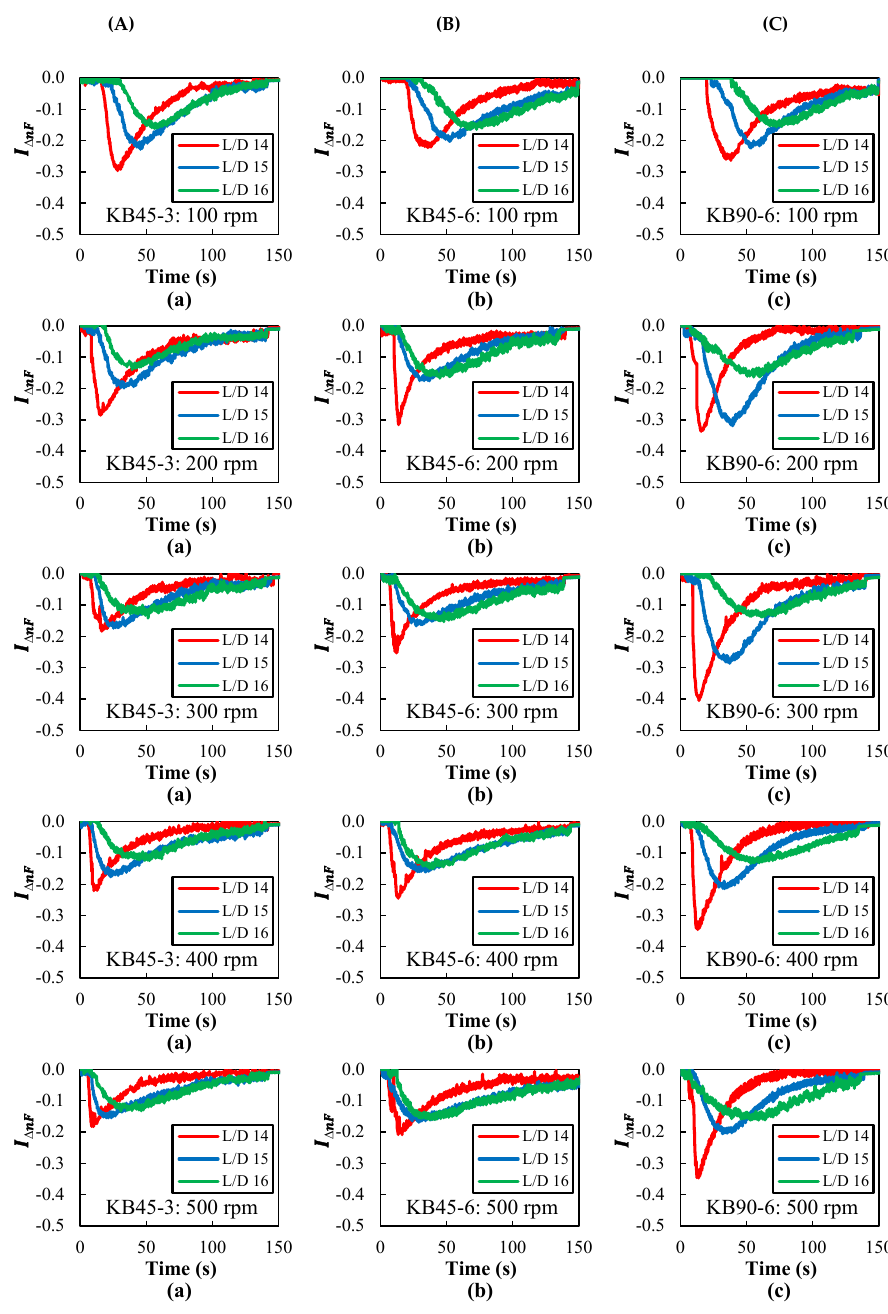
Figure 10. Normalized cross-polarized transmitted light intensity ( I ∆ n ( A – C : ports L/D = 14, 15, and 16) for different kneading blocks: ( a ) KB45-3, ( b ) KB45-6, and ( c ) KB90-6 at various screw speeds (100 to 500